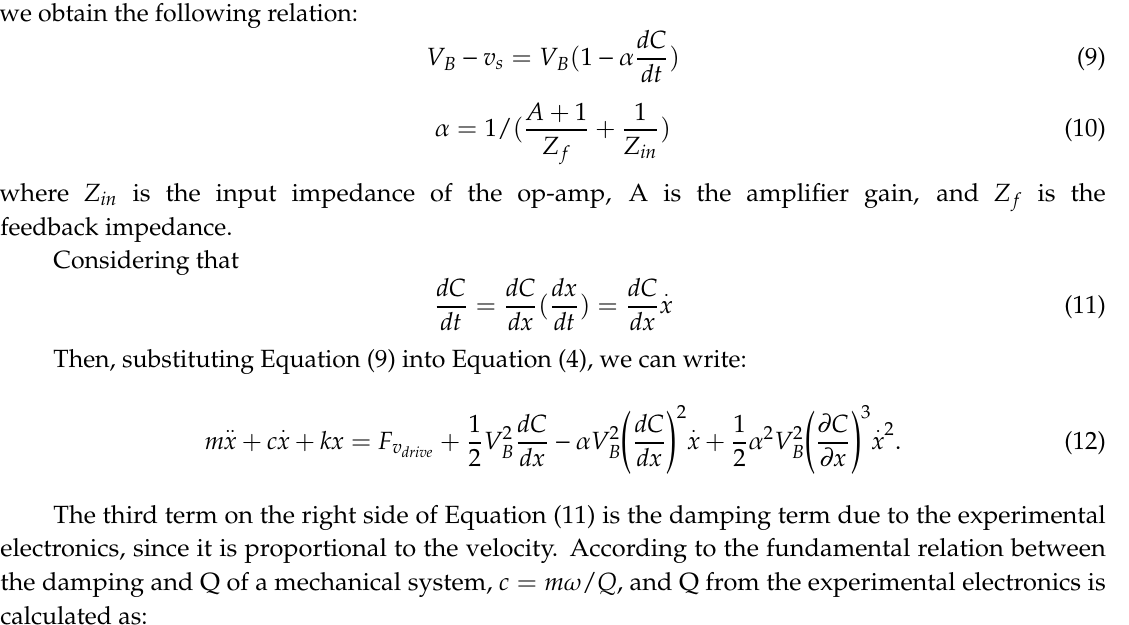
Table 3. System parameter of the DRG.